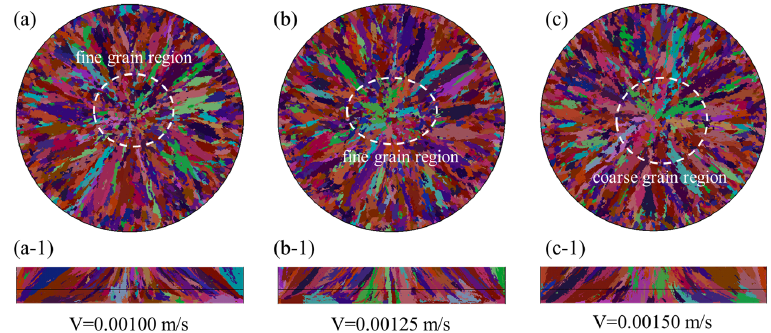
Figure 11. Simulated solidification structure under different casting speed, where ( a – c ) are the cross ‐ section structure of billet, (a ‐ 1–c ‐ 1) present the longitudinal section structure of billet; the cast speed conditions are 0.00100 m/s (a and a ‐ 1), 0.00125 m/s (b and b ‐ 1), and 0.00125 m/s (c and c ‐ 1), respectively.